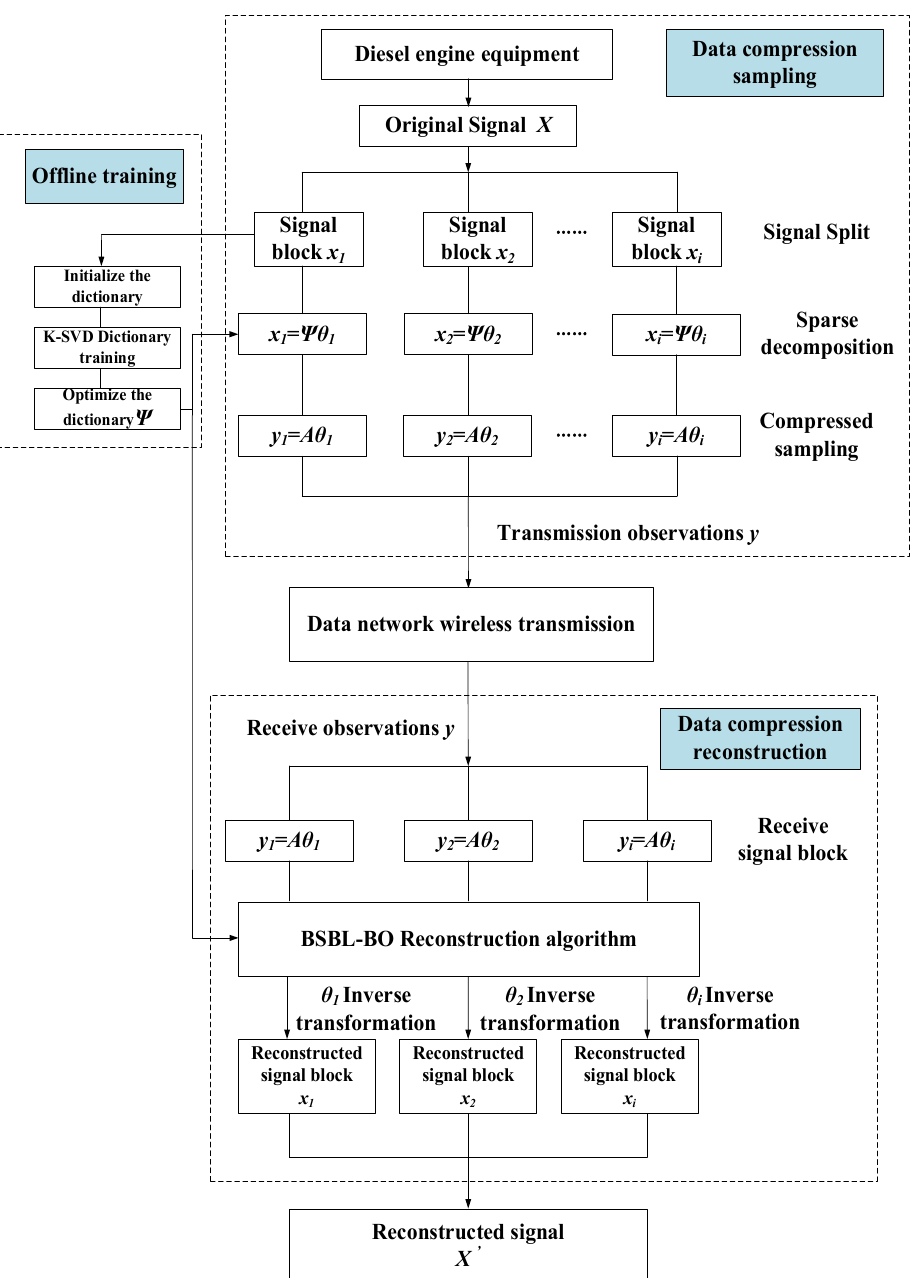
Figure 1. BSBL-KSVD compression reconstruction algorithm flow.